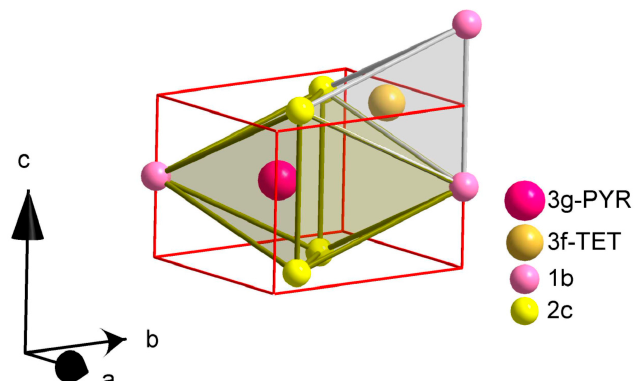
Figure A1. The crystal structure of the Mn 2 − x Fe x P 1 − y Si y compounds (Fe 2 P type, SG P-62m), showing the environments of the two metal sites (3f for TET, 3g for PYR) and the two non-metal sites at 1b and 2c positions. In fact, the index δ = d ( 2 c -2 c )/c − 1 is determined from the ratio of planar (p) and axial (a) edges of the tetrahedral site (TET). Table A1. A comparison of interatomic distances for two selected parent systems.